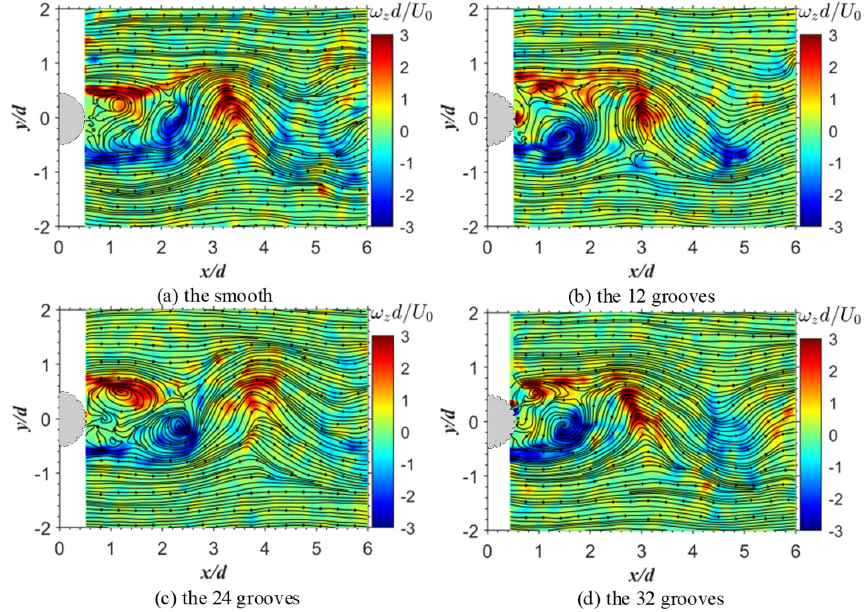
Figure 11. Instantaneous streamlines and normalized vorticity contours in the (x, y)-plane.